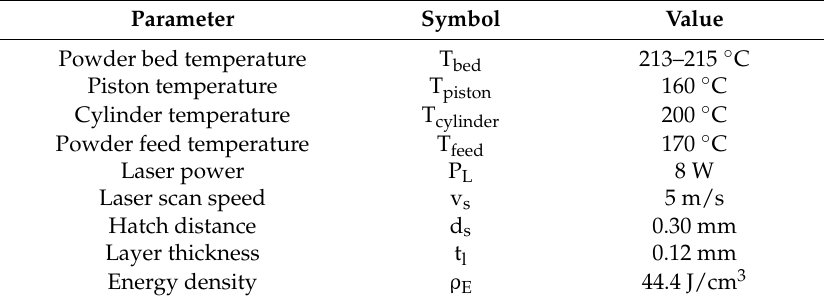
Table 1. Laser sintering process